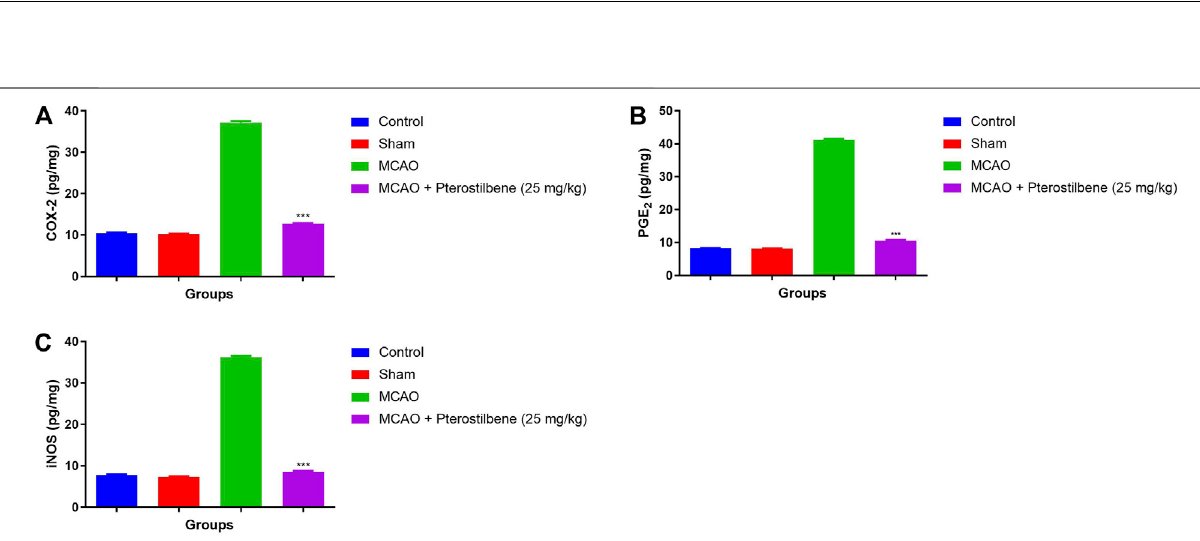
Frontiers in Pharmacology |